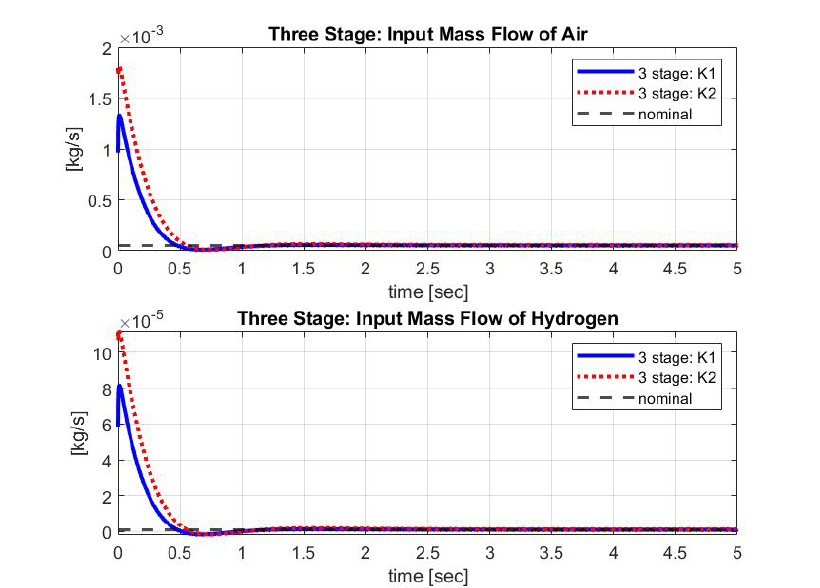
Figure 12. System inputs comparison. From simulation results can be seen that by fine tuning input(actuator) saturation and physical limitation can be avoided. Controller K 2 requires higher mass flow values of the input gases, while controller K 1 is more